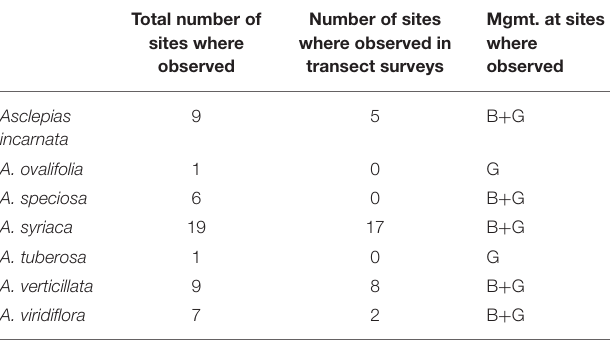
TABLE 2 | Summary of the total number of sites where each milkweed species was observed (transect surveys + meandering walk), the number of sites where each milkweed species was observed in transect surveys only and the management (B = burned, G = grazed) at sites where milkweed species were